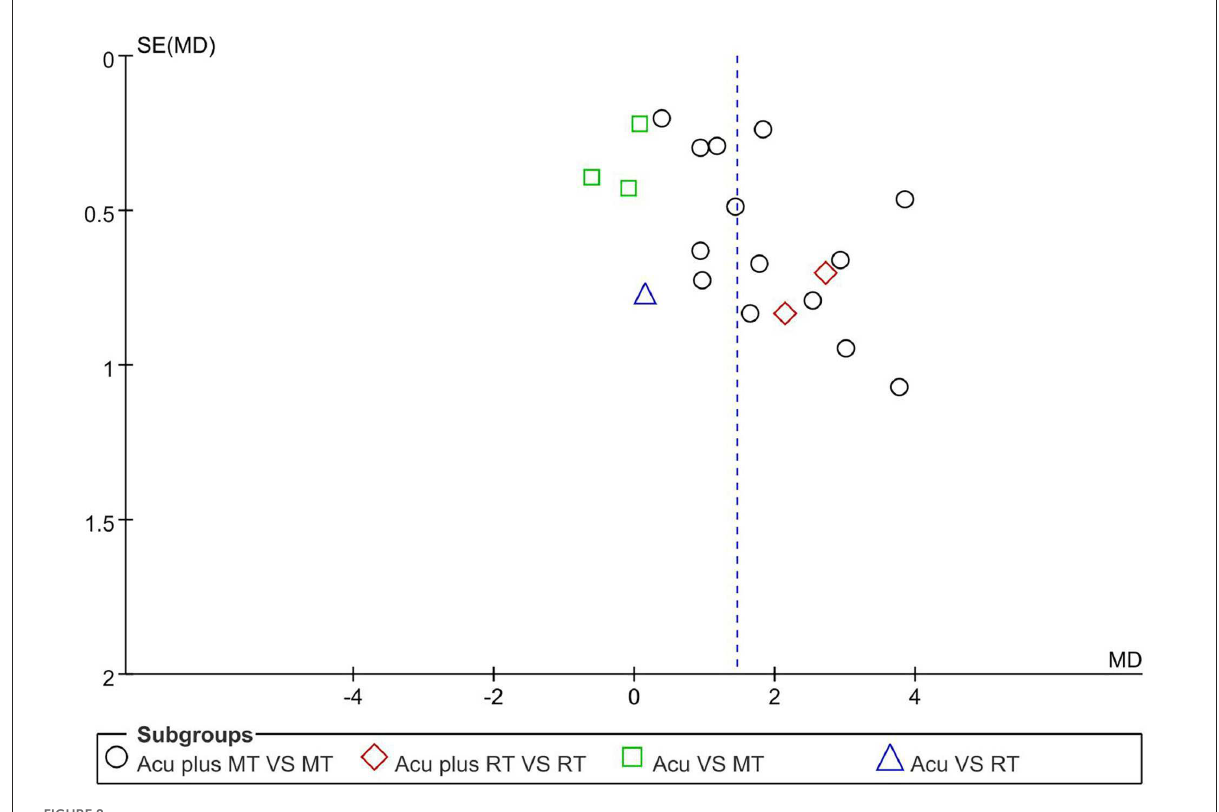
FIGURE8 Funnel plot of GCS (Glasgow coma